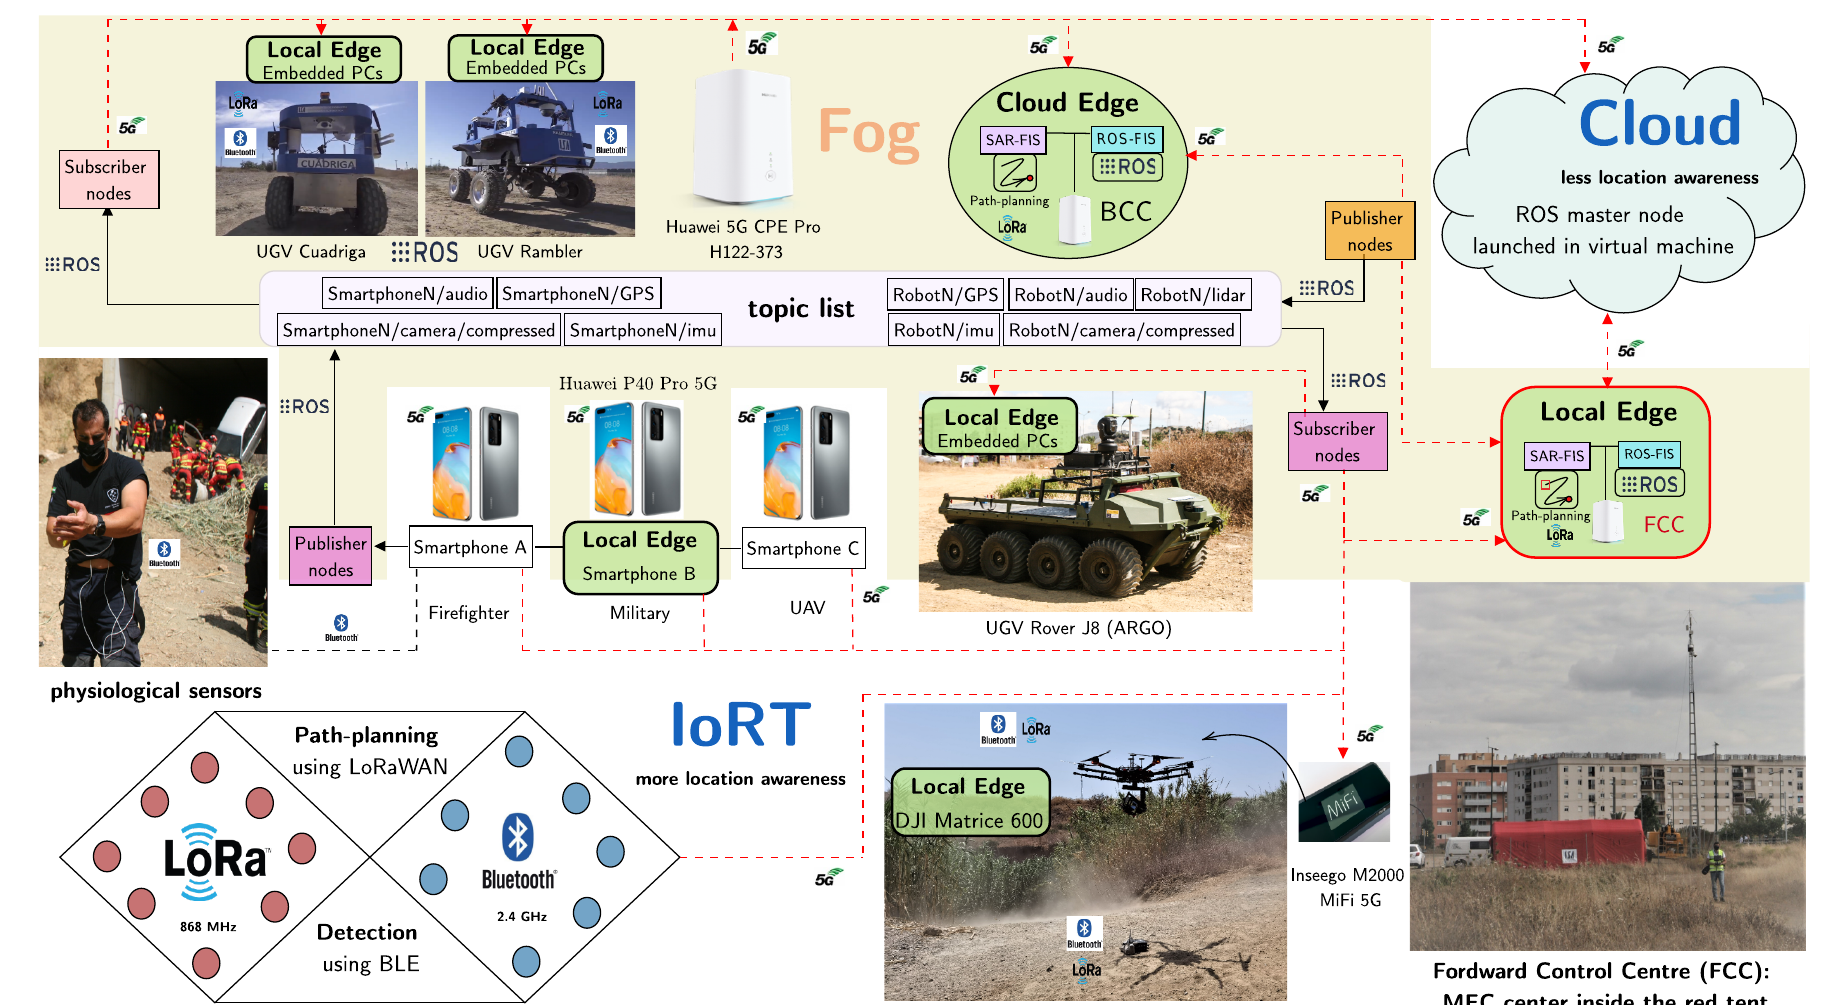
Figure 2. System architecture for search and rescue missions